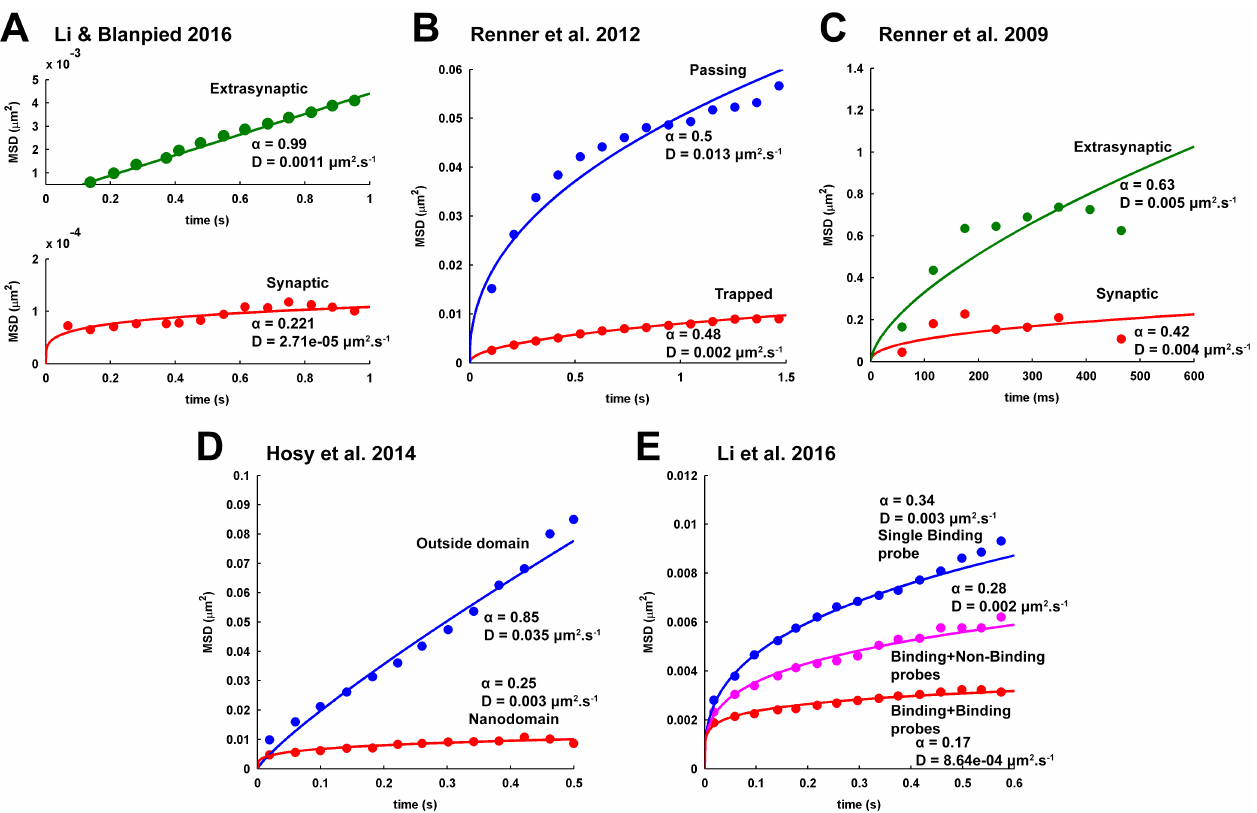
Fig 10. Analyzing some recent experimental data on the MSD of AMPAR diffusion at excitatory synapses for the anomalousity of receptor diffusion. The experimental data (A-E) on the nature of AMPAR diffusion, in terms of the temporal profiles of the MSD, obtained in the studies by Li and Blanpied (see ref. [76] in the main text), Renner et al. (ref. [24]), Renner et al. (ref. [77]), Hosy et al. (ref. [79]), and Li et al. (ref. [29]) using high-resolution microscopic techniques are shown in filled circles. Fitting of the standard relation between MSD and time for two-dimensional diffusion, given by h r 2 i = 4 Dt α , to the data is shown with solid line. It yields the anomalous exponent α and the constant parameter D of the receptor diffusion. The estimated α of diffusion under different conditions are used here in the text to discuss the possible involvement of the self-crowding factor of AMPARs in the observed nature of their diffusion.